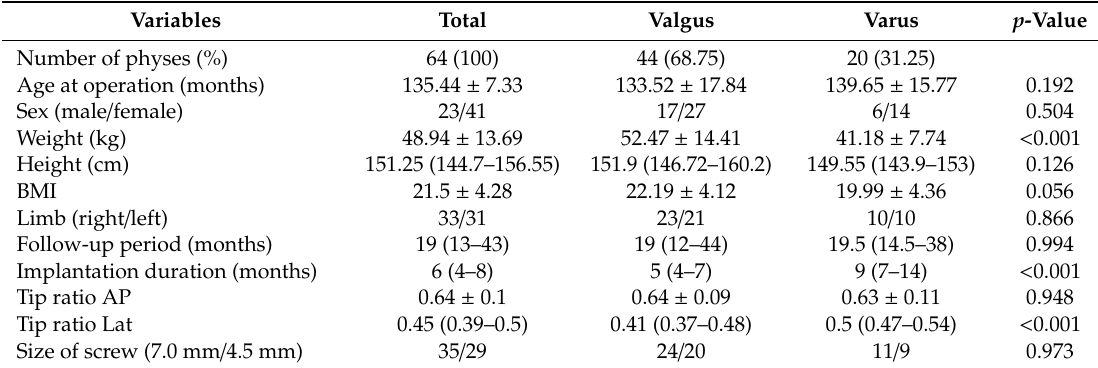
Table 1. Patients’ demographics and summary of screw